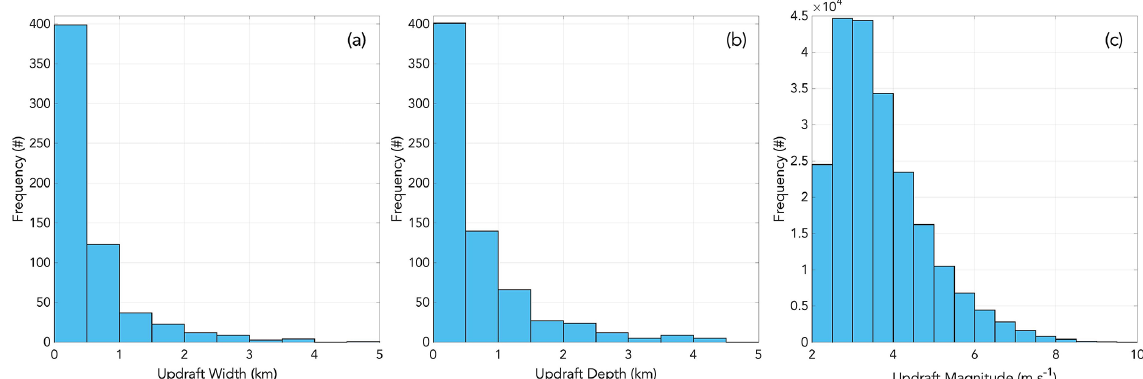
Figure 3. For all 13 COMBLE cases, histograms of (a) updraft chord length (width) in km, (b) updraft vertical extent in km, and (c) the range of magnitudes in the updraft in ms − 1